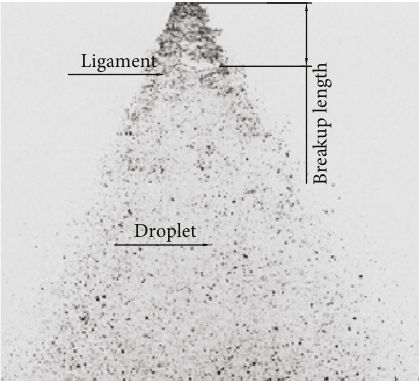
Figure 7: Scatter of measurement data points of C to (5).